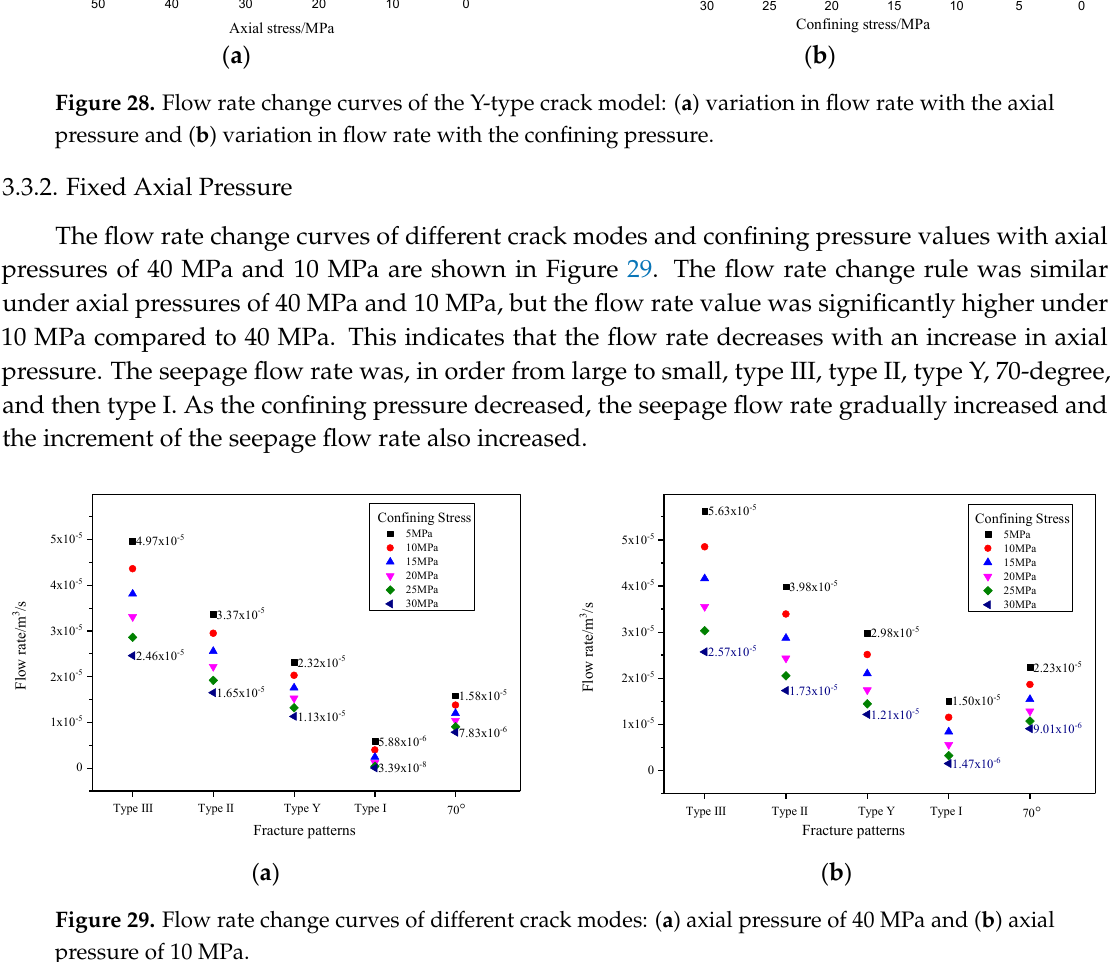
Figure 28. Flow rate change curves of the Y-type crack model: ( a ) variation in flow rate with the axial pressure and ( b ) variation in flow rate with the confining pressure.